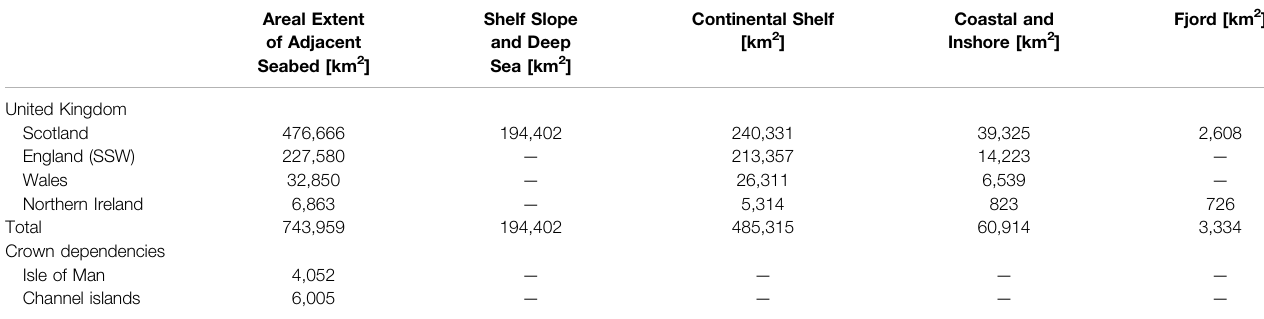
TABLE1| Arealextent[km 2 ]ofadjacentwatersmanagedbythefourgovernmentsoftheUKandtheUKCrownDependencies.Seabedextentdatawereaccessedfromthe Maritime limits portal of the